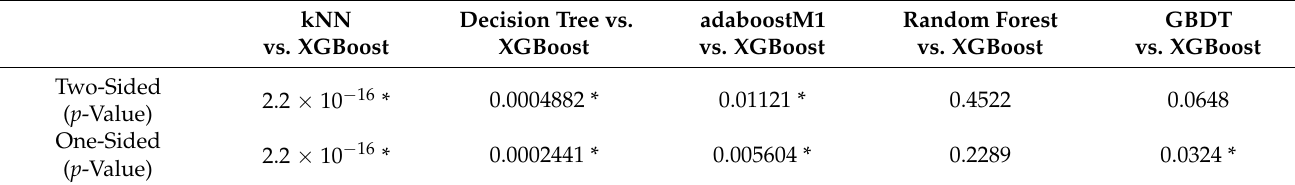
Table 7. Kolmogorov-Smirnov predictive accuracy test (15